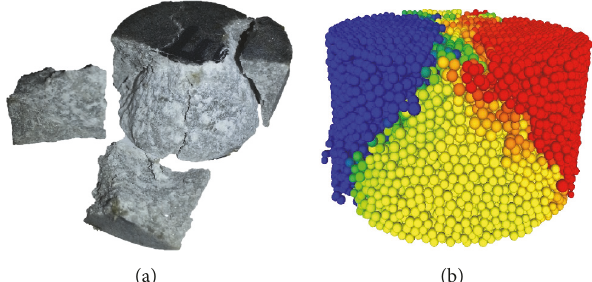
Figure 6: Epoxy cylinder after failure in compression for experimental (a) and DEM simulation with principal stress criterion (b).